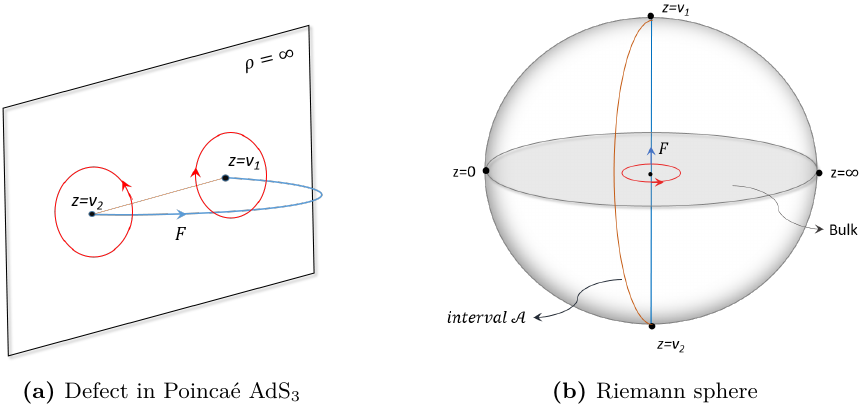
Figure 1. (a). In Poincaré AdS 3 , the boundary defects extend continuously into the bulk as a Wilson line defect, inducing a non-trivial holonomy along the geodesic. (b). The endpoints of the boundary interval A are transformed to the south pole and north pole of the Riemann